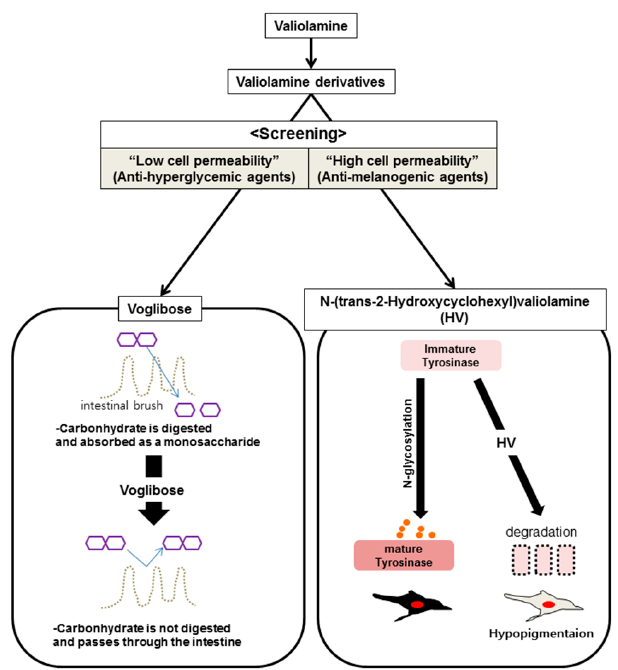
Figure 2. To develop an anti-hyperglycemic agent that works on the surface of the intestinal brush border, numerous valiolamine derivatives with low cell permeability were screened. In contrast, anti-melanogenic agents require high cell permeability to penetrate the skin barrier and influence melanocytes to inhibit N -glycosylation. An alternative screening method that depends on cell permeability could be used for screening for an effective anti-melanogenic agent, such as N -( trans -2-hydroxycyclohexyl)valiolamine (HV).